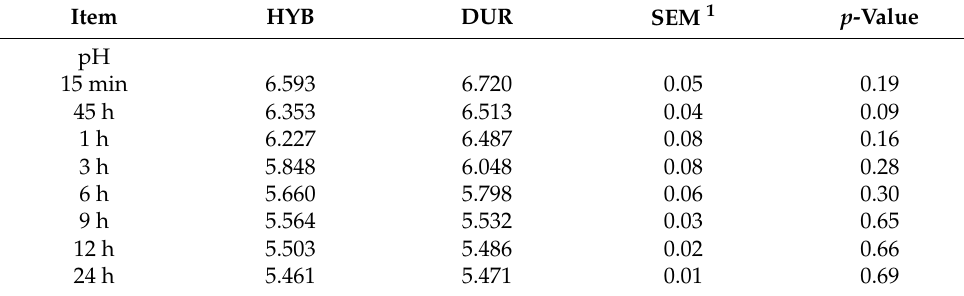
Table 7. Carcass pH of pigs of different genetic